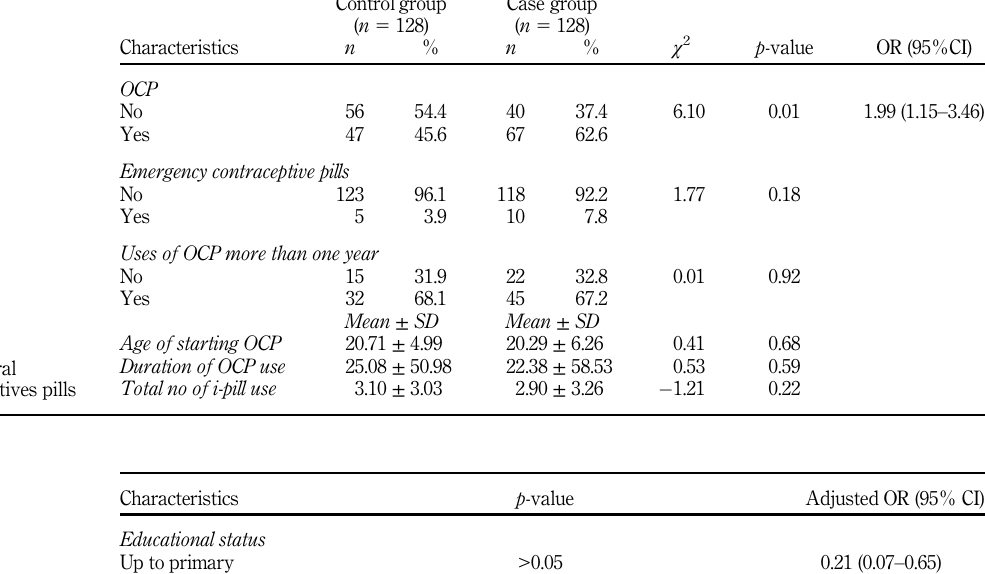
Table 3. Adjusted odds ratio of the significant variables (after removing the effect of other